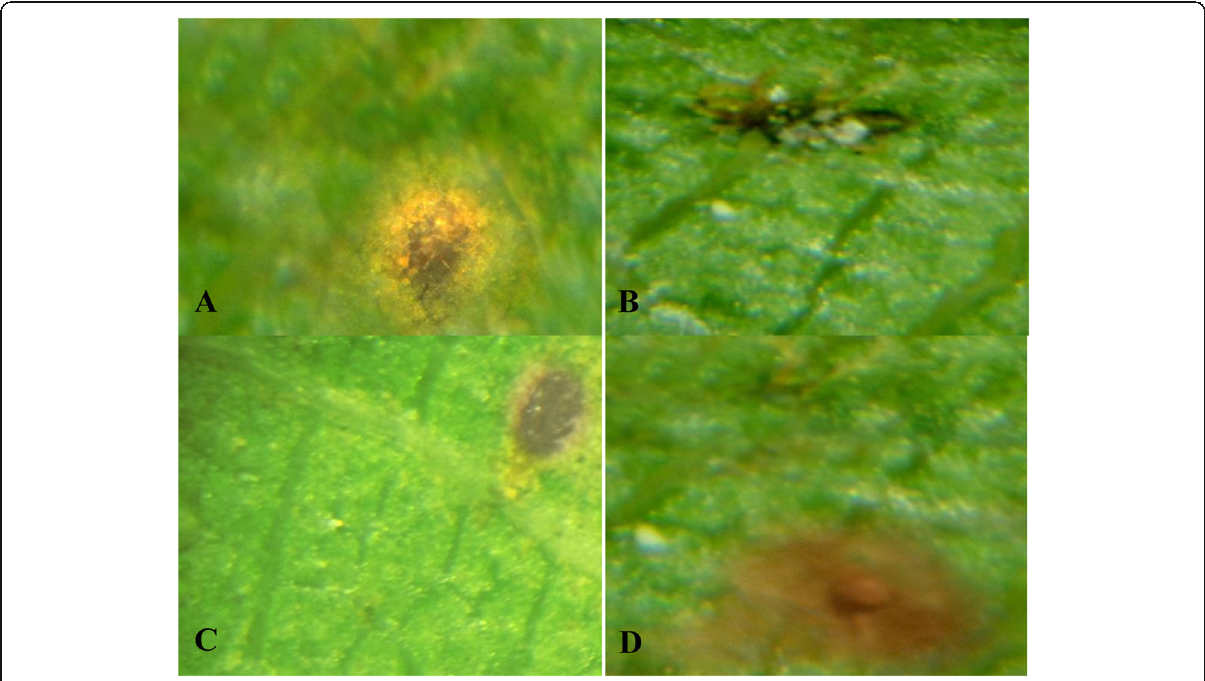
Fig. 5 a. Individuals of T. urticae infected with M. anisopliae after 7 days treatment. b. T. urticae individuals infected with B. bassiana after 4 days treatment. c. T. urticae individuals infected with V. lecanii after 7 days treatment. d. T. urticae individuals infected with T. harzianum after 7 days treatment (all images were taken with a Leica EZ 4D dissecting microscope at ~ ×